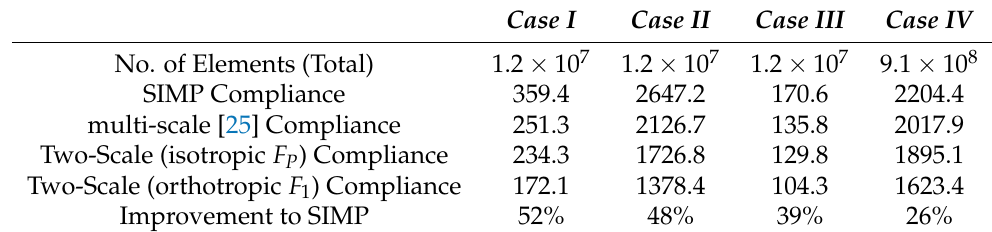
Figure 11. Final optimized structures and their compliance values with different microstructures properties and comparison results with other TO methods: ( a – c ): three benchmark problems ( F = 1 in all three cases); ( d – l ): optimal structure of the two-scale TO method [49] with isotropic and orthotropic microstructures; ( m – r ): optimal structures using multi-scale [25] and SIMP methods, respectively. Table 5. Structural performance comparison of different TO methods on four benchmark